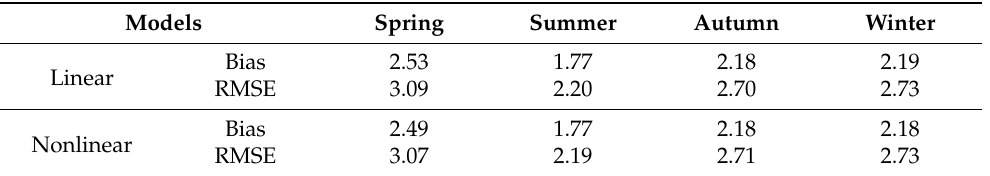
Table 12. The biases and RMSE of the linear and nonlinear seasonal multifactor RTMs-derived T m in the Yangtze River Delta region during 2016–2017